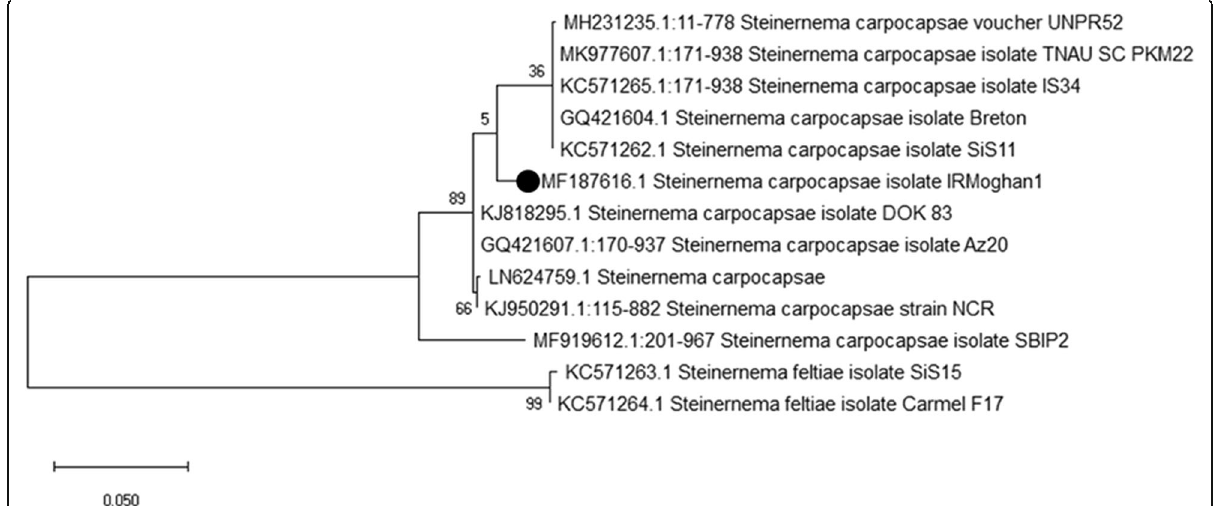
Fig. 1 Evolutionary relationships of new EPN isolate (IRMoghan1). The evolutionary history was inferred using the Neighbor-Joining method. The percentage of replicate trees in which the associated taxa clustered together in the bootstrap test (500 replicates) was shown next to the branches. The evolutionary distances were computed using the Maximum Composite Likelihood method. The tree was drawn to scale, with branch lengths measured in the number of substitutions per site